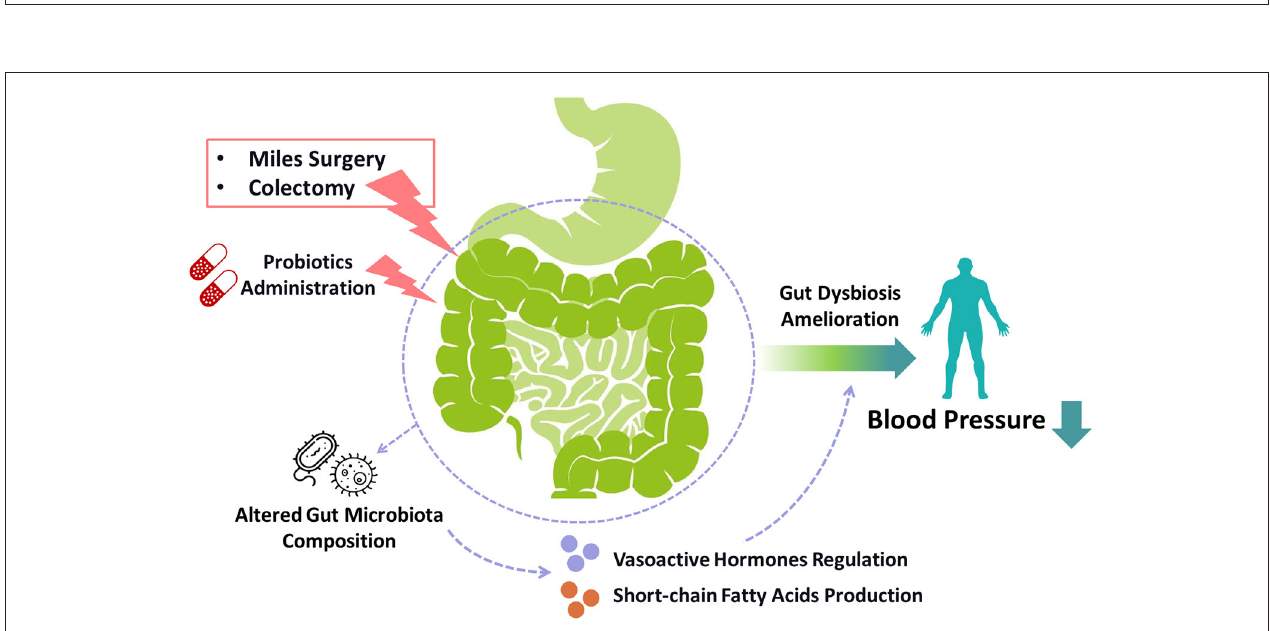
FIGURE 2 | Gut intervention-induced microbiota alteration in blood pressure control. Gut interventions targeting colorectal regions such as miles surgery and colectomy, as well as probiotics administration, may ameliorate hypertension by modulating gut dysbiosis. These gut surgeries and exogenous probiotic supplements altered gut microbiota composition to regulate the production of vasoactive hormones and short-chain fatty acids, which could be the underlying mechanisms of the reduction of blood pressure. The administration of probiotics might also be a novel strategy for treating hypertension.